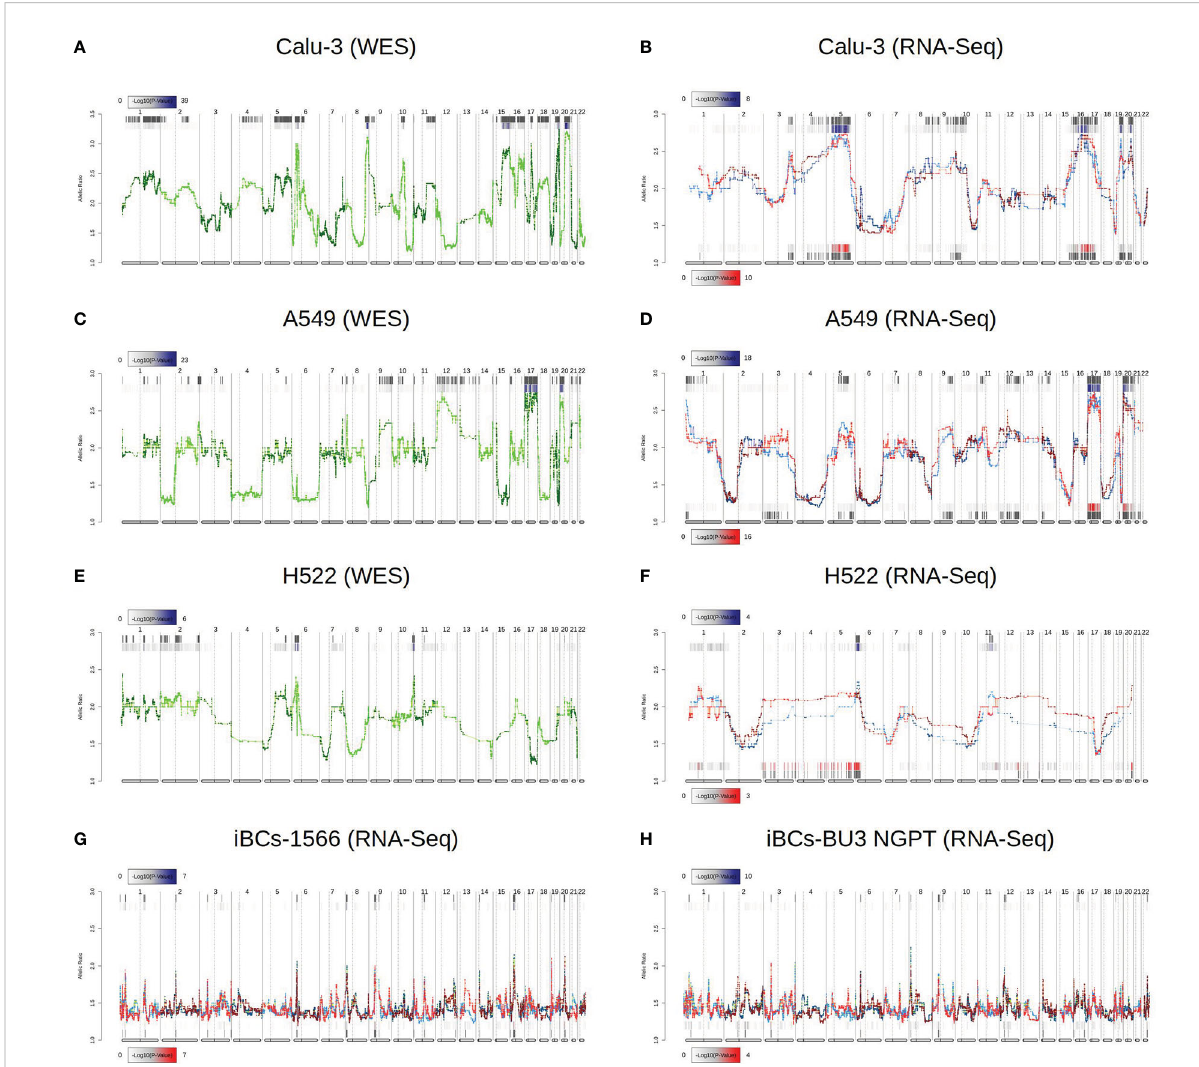
FIGURE 3 Comparison of chromosomal aberrations between mock-treated and SARS-CoV-2-infected cell lines. Comparison between e-Karyotyping analysis of samples from whole-exome sequencing and RNA-Seq data from Calu-3 (A, B) , A549 (C, D) , and H522 (E, F) . (G, H) e-Karyotyping analysis in RNA-Seq data from iPSC-derived airway epithelium basal cells (iBCs) from 1566 and BU3 NGPT cell lines. For each experiment, red dots and lines represent SARS-CoV-2-infected replicates, whereas blue dots and lines show mock-treated replicates. Diploid samples usually display an allelic ratio (y-axis) around 1.4 as previously shown (44, 51). The gray background shown at the top and bottom of each plot shows regions that reach statistical signi fi cance for aneuploidy using the piecewise constant fi t algorithm. The color gradient displayed next to each region represents the FDR-corrected P value for both